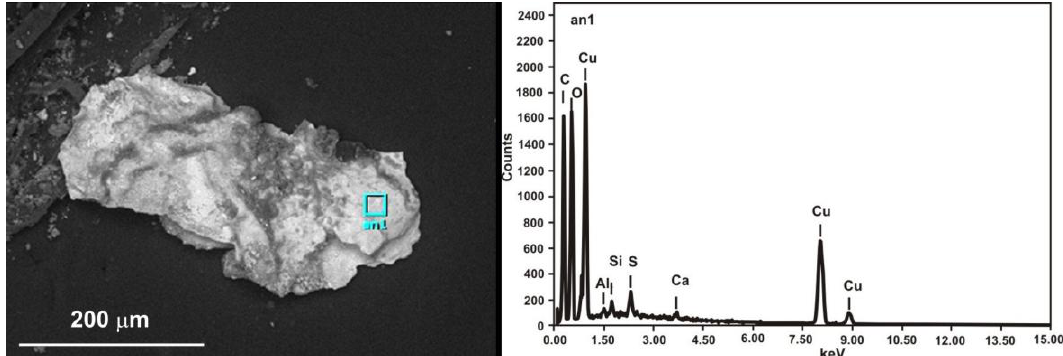
Figure 23. Bracelet micro-sample SEM photograph (on the left) and EDS spectrum (on the right).